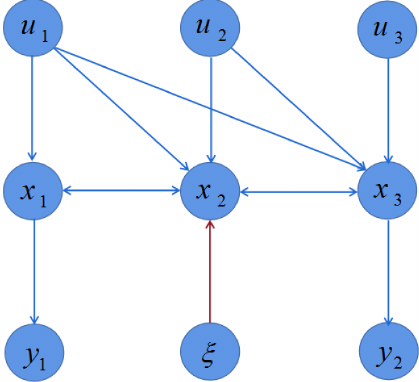
Figure 2. Network diagram of system